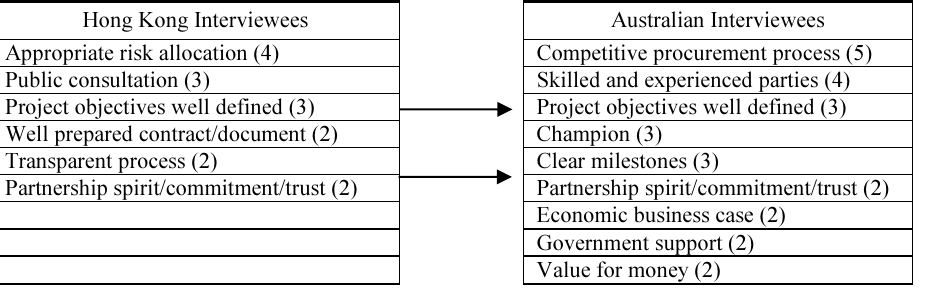
Table 10. Question 5 – In general, what do you think are the critical success factors leading to successful PPP